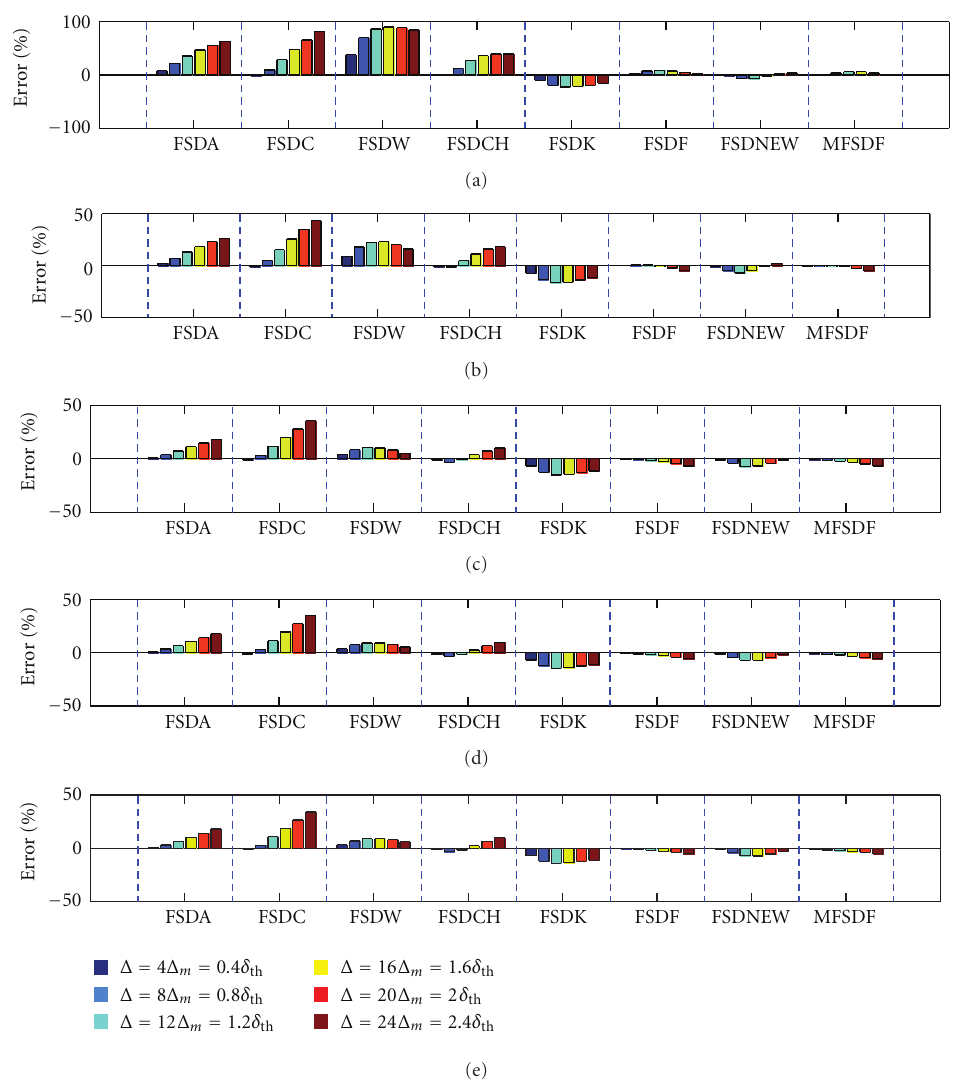
Figure 3: Percentage error (13) of the model prediction from (cid:5) Σ gen (cid:6) obtained from DNS for LES filter widths Δ = 4 Δ m = 0 . 4 δ th ; Δ = 8 Δ m = 0 . 8 δ th ; Δ = 12 Δ m = 1 . 2 δ th ; Δ = 16 Δ m = 1 . 6 δ th ; Δ = 20 Δ m = 2 . 0 δ th ; Δ = 24 Δ m = 2 . 4 δ th for (a–e) cases